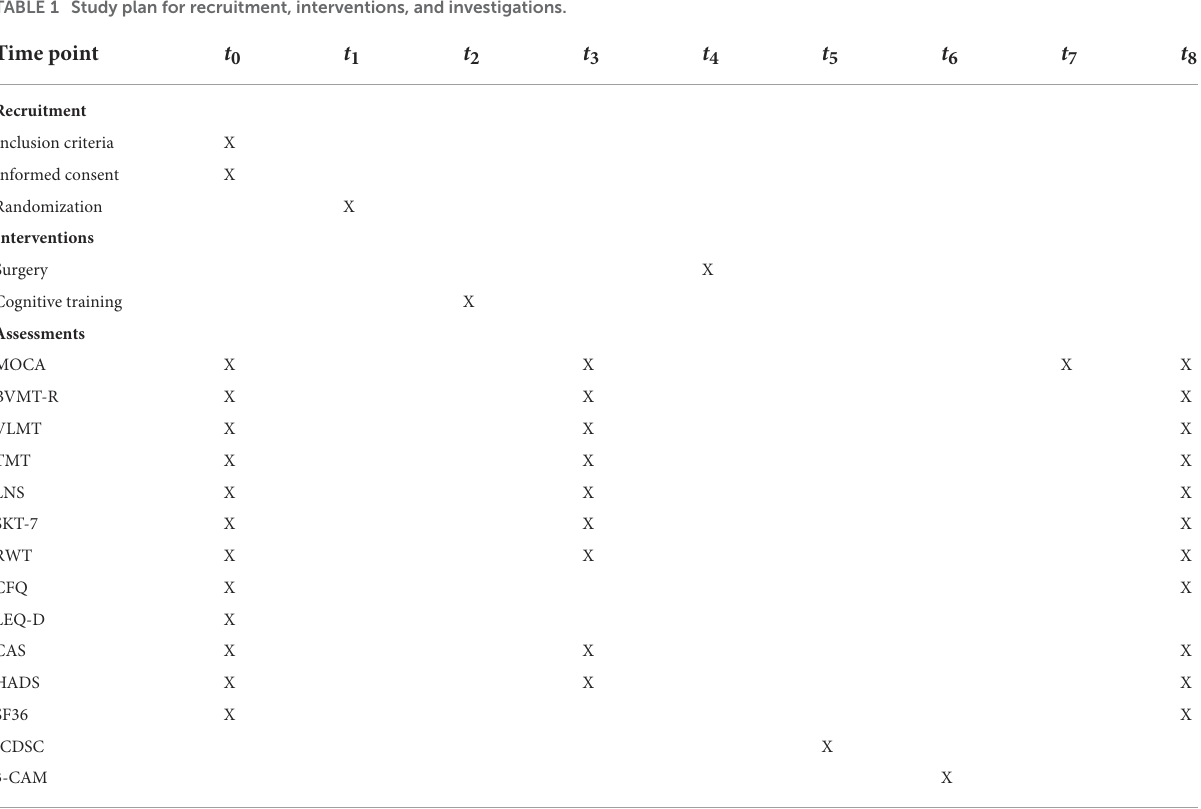
TABLE 1 Study plan for recruitment, interventions, and